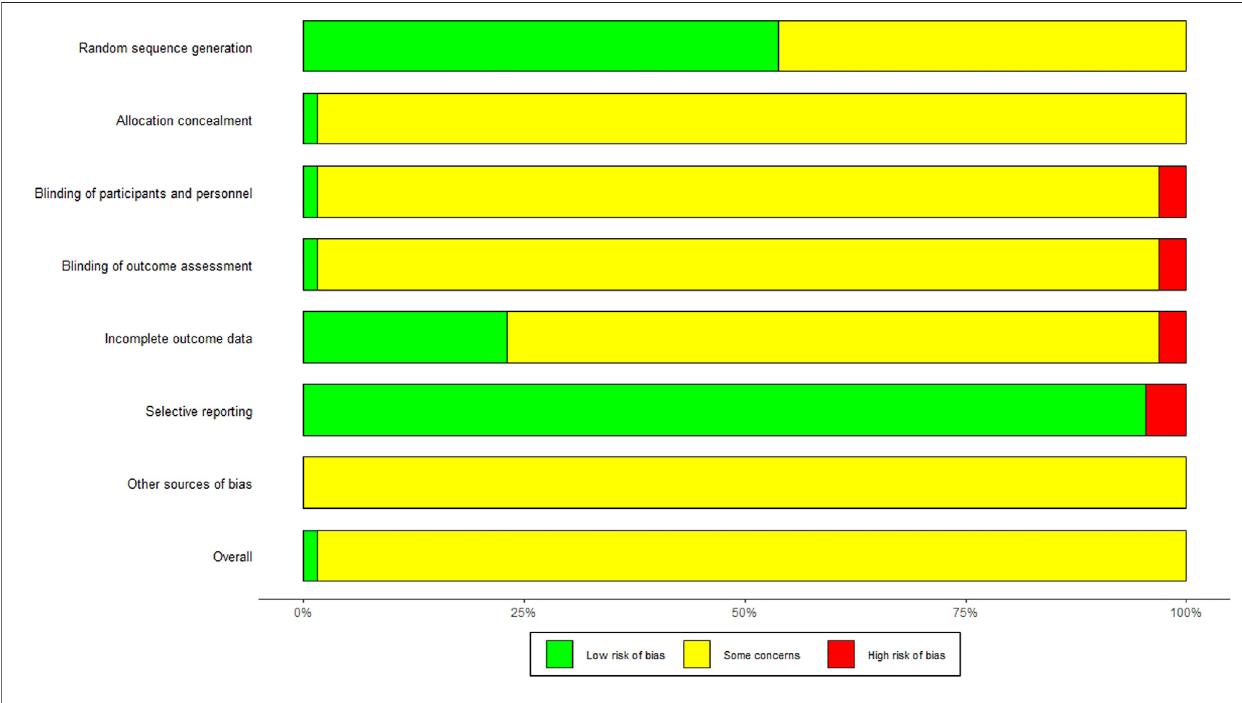
FIGURE 2 | Evaluation for bias risk of included